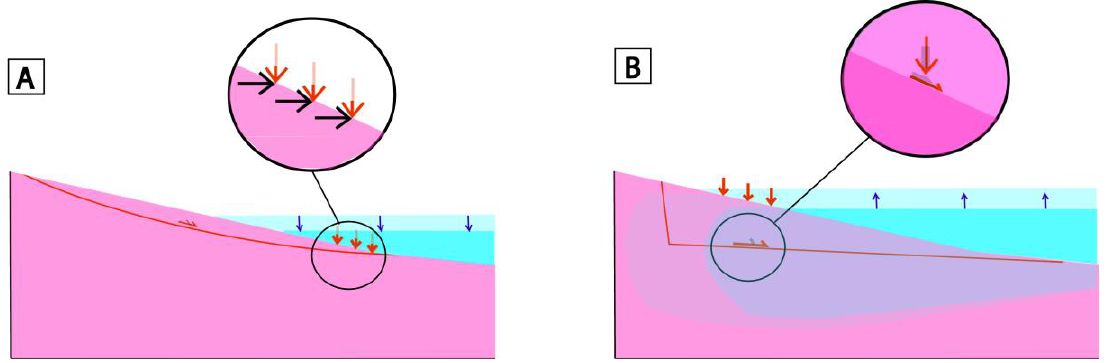
Figure 7. Influence of the sea level variation with respect to the position of the center of mass of the potential sliding area: ( A ) Slope instability caused by sea level lowering when the load is located at the base of the slope, ( B ) slope instability caused by a sea level rise above the center of mass with seawater infiltration.